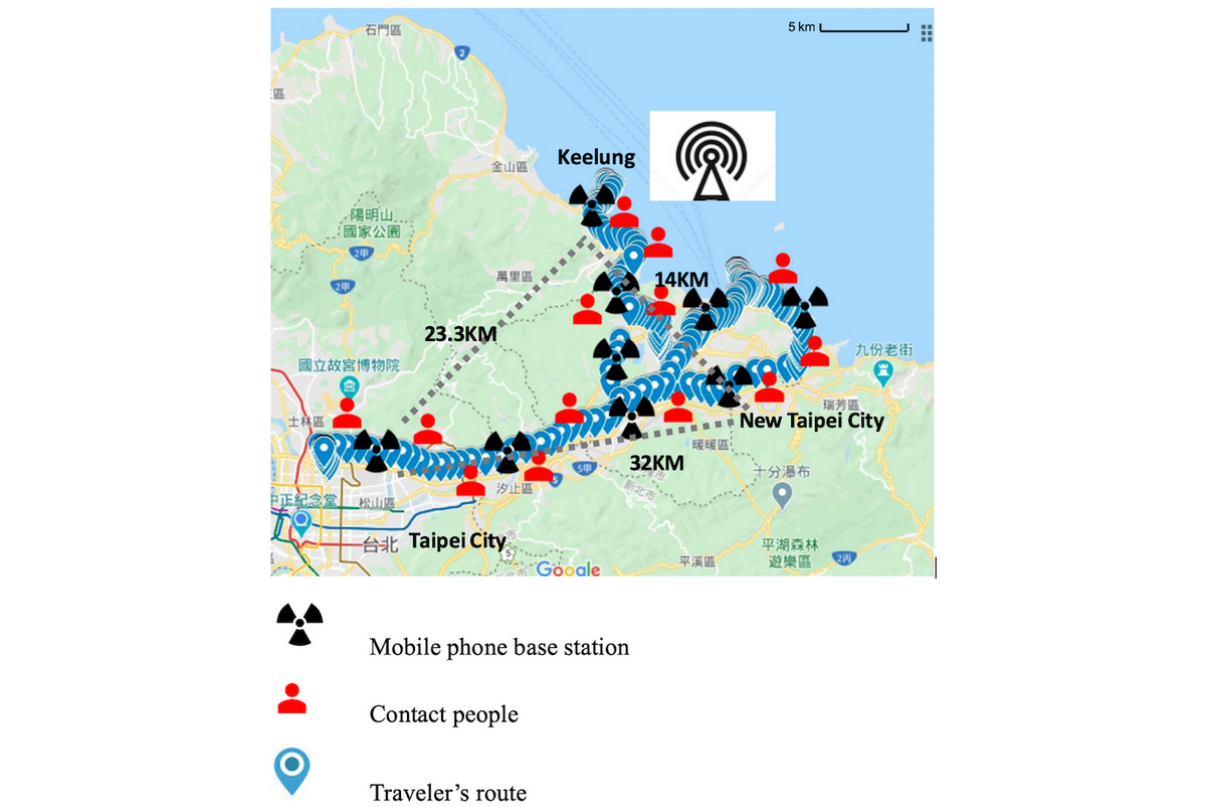
Figure 1. Passengers' routes of the 1-day tour on January 31, 2020, in Taiwan.